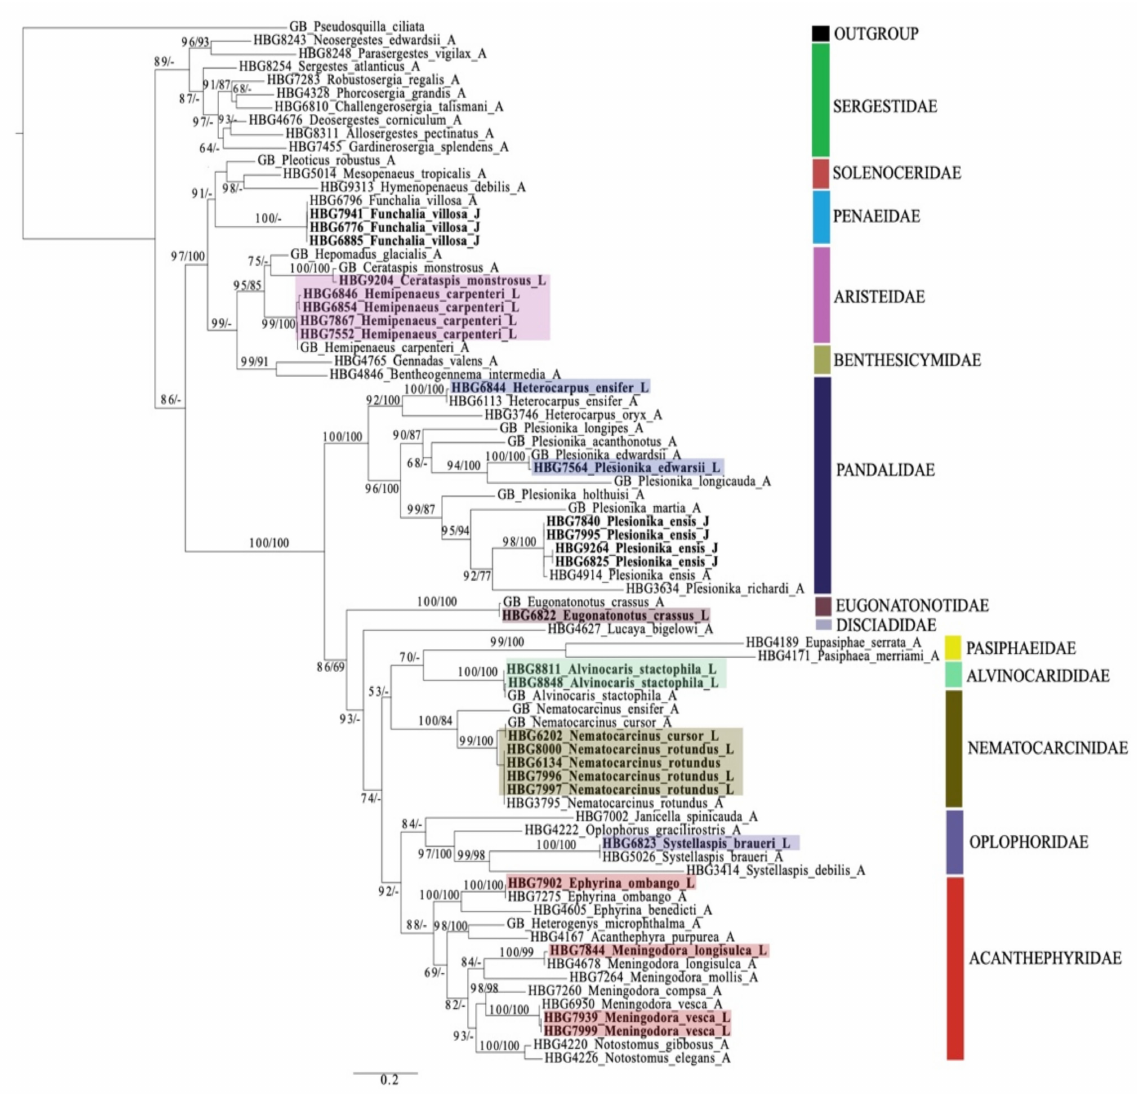
Figure 3. Maximum likelihood (ML) phylogeny of 51 barcoded individuals from the infraorder Caridea and suborder Dendrobranchiata based on the mitochondrial genes, 16S and COI. The number along the branches represent ultrafast bootstrap support (UFboot) values and Bayesian posterior probabilities (pp), respectively. UFBoot and pp values >95 indicate strong support. Voucher numbers (HBG#) represent specimens in the Florida International Crustacean Collection (FICC) and GB represents GenBank sequences. Family names are listed along the vertical bars. A = adult representative, J = juvenile representative and L = larval representative. Highlighted individuals represent the larvae matched with their adult